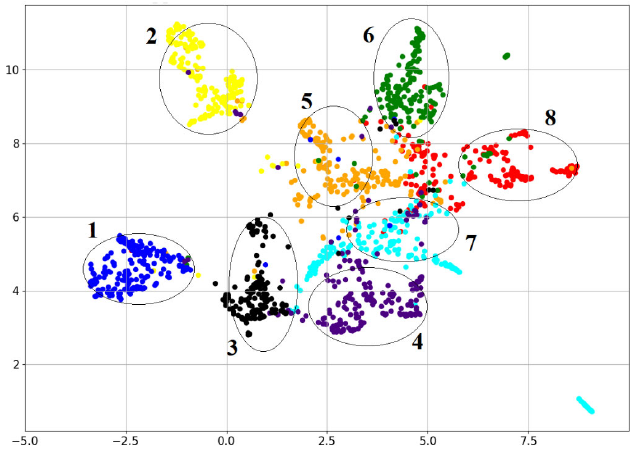
Figure 6. Graphical representation of averaged values of cosine metrics for a marked corpus of documents, as obtained using matrices of cosine metric values using the lexical and semantic approaches (here 1, 2, 3, 4, 5, 6, 7, 8 are the numbers of clusters).